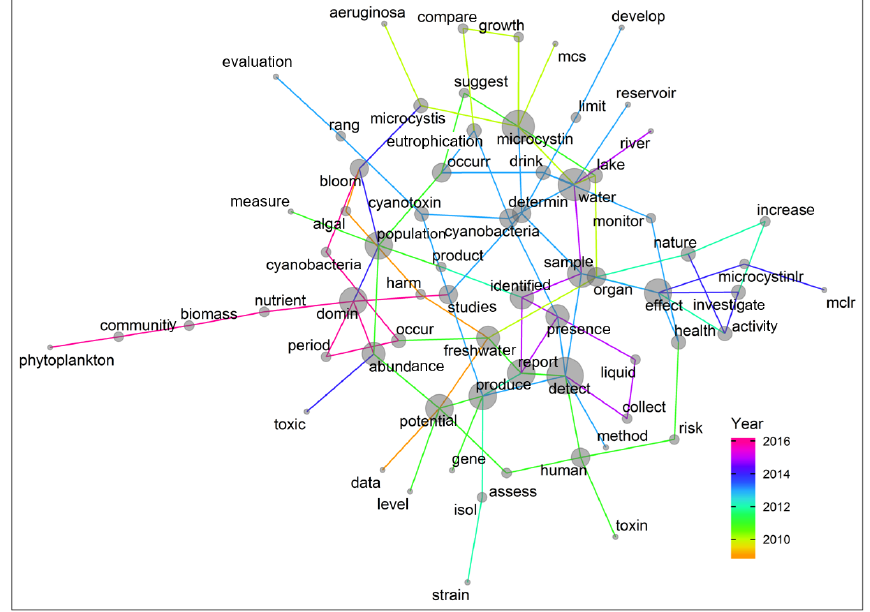
Figure 5. Network diagram generated based on an LDA topic model.